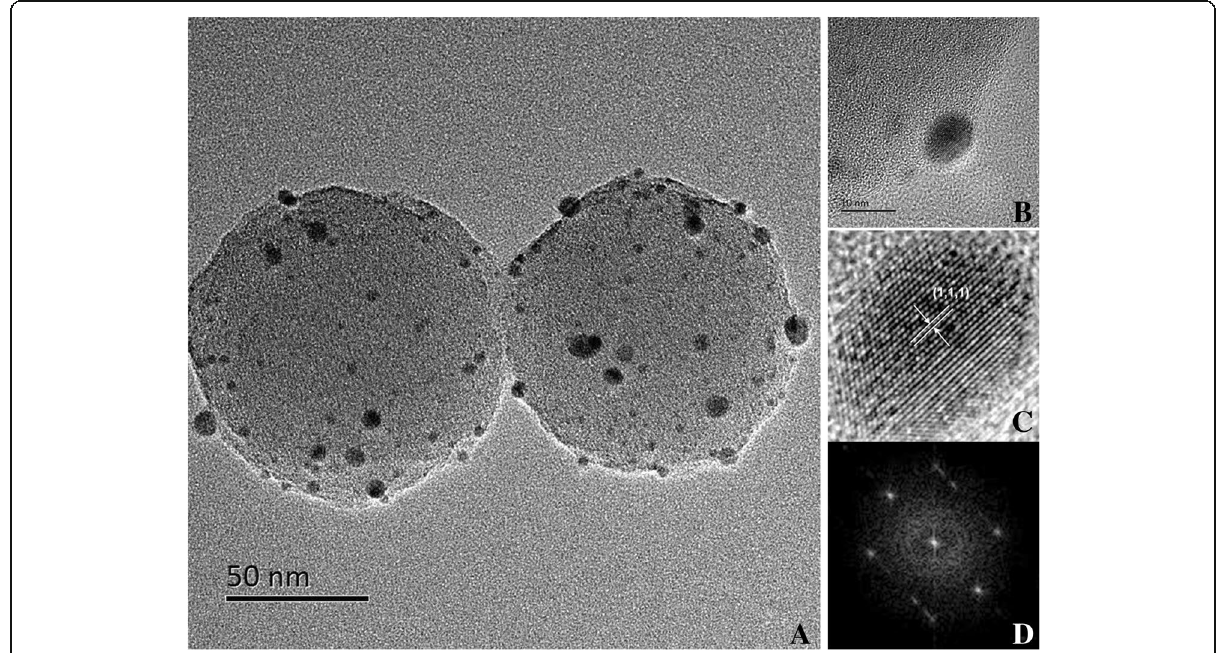
Fig. 3 HR-TEM images of Pd-carbon nanospheres ( a ), magnified images of Pd nanoparticles ( b, c ) and FFT images of Pd nanoparticles ( d